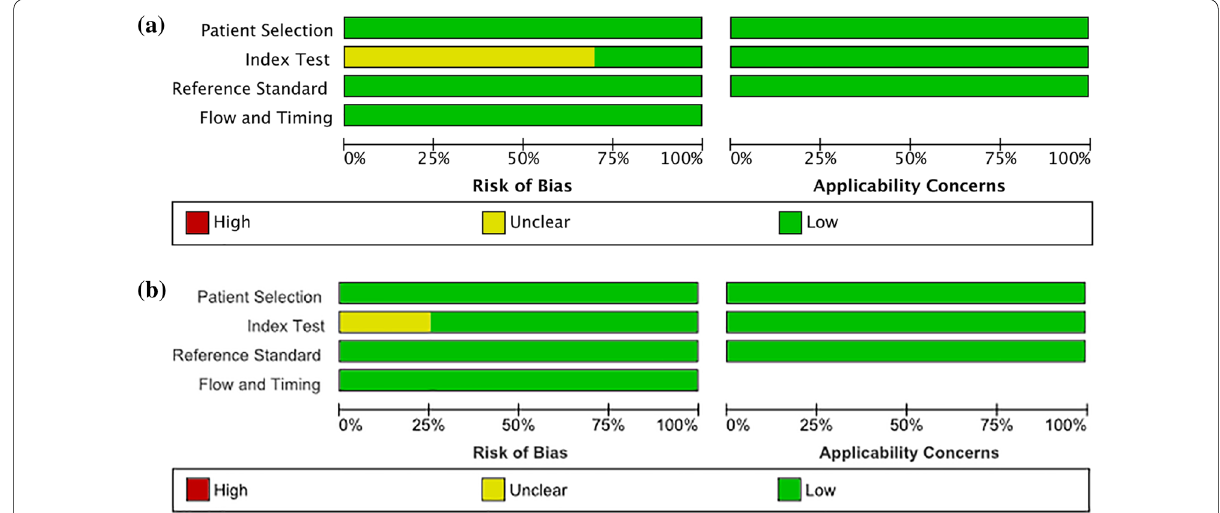
Fig. 2 a Barplot of risk of bias and applicability concerns across all ADC studies assessed by QUADAS2. b Barplot of risk of bias and applicability concerns across all FA studies assessed by